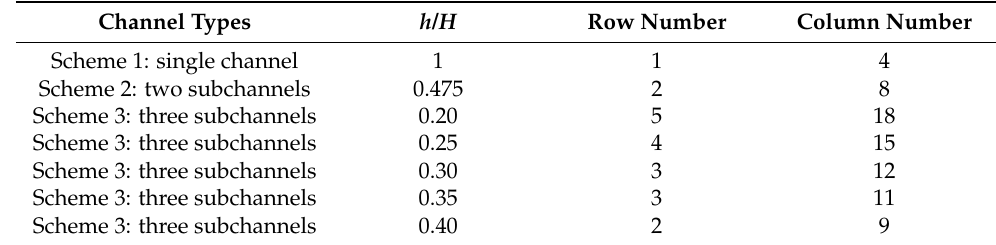
Table 1. Structural parameters of X-shaped truss array channels for different layout schemes (based on the optimization results at Re = 60,000 in [41]).